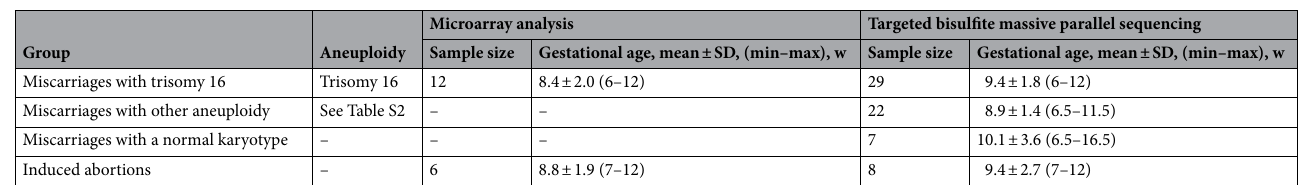
Table 3. Characteristics of miscarriages with a normal karyotype, miscarriages with aneuploidy and induced abortions.